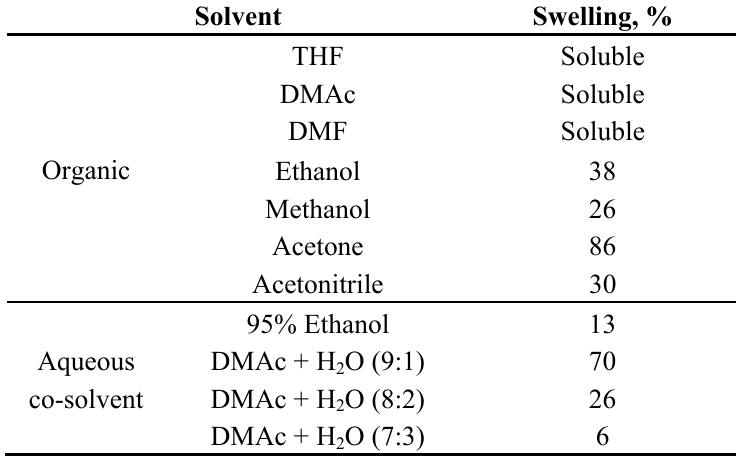
Table 3. Solubility and swelling properties of a polycarbonate urethane at 25